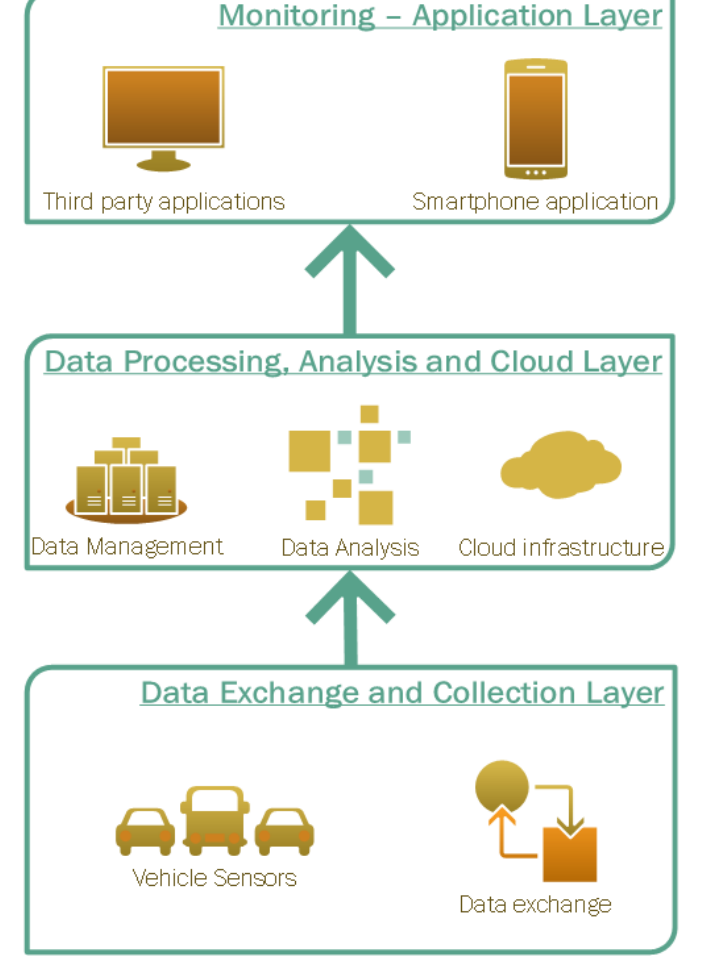
Figure 1. The 3-layers of the DBDA architecture.